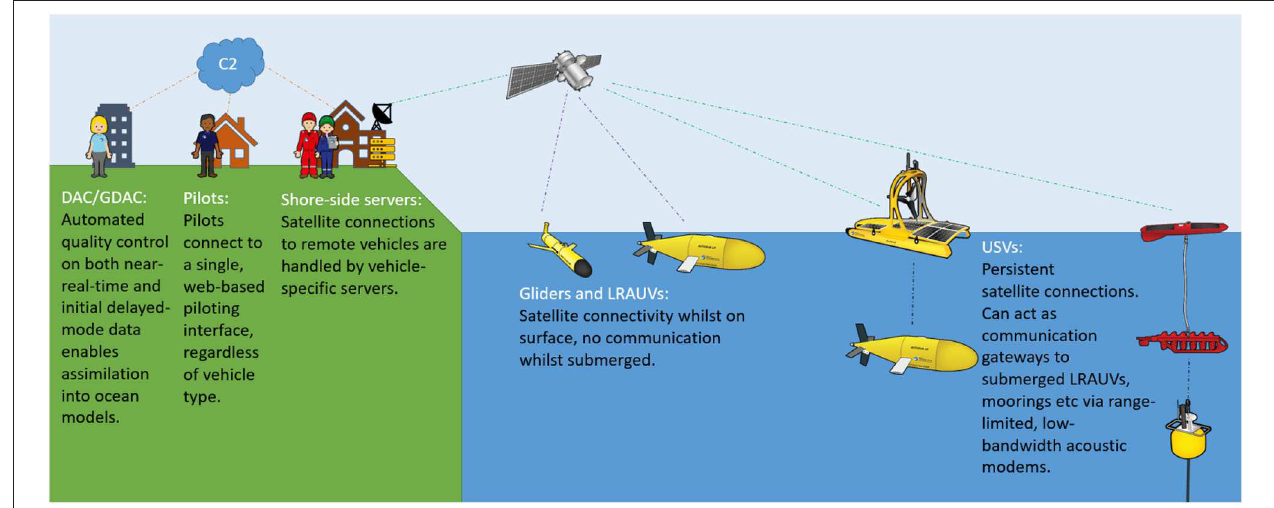
FIGURE 3 | Generalized representation of key interactions with the C2 system, showing the operating modes of vehicles within the long-range MARS